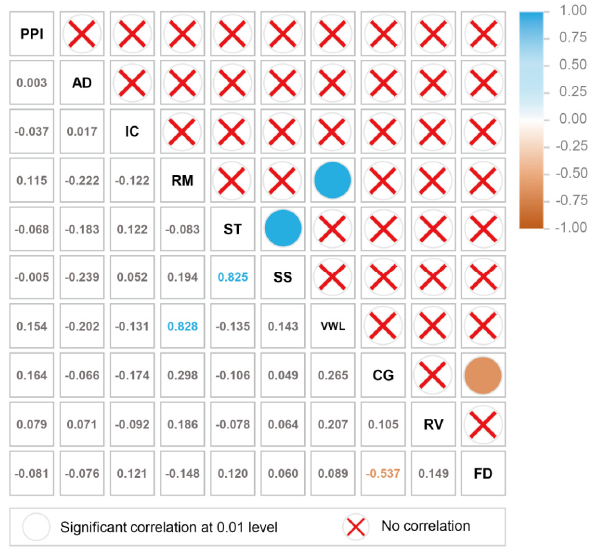
Figure 5. Correlation matrix among the predictor variables.